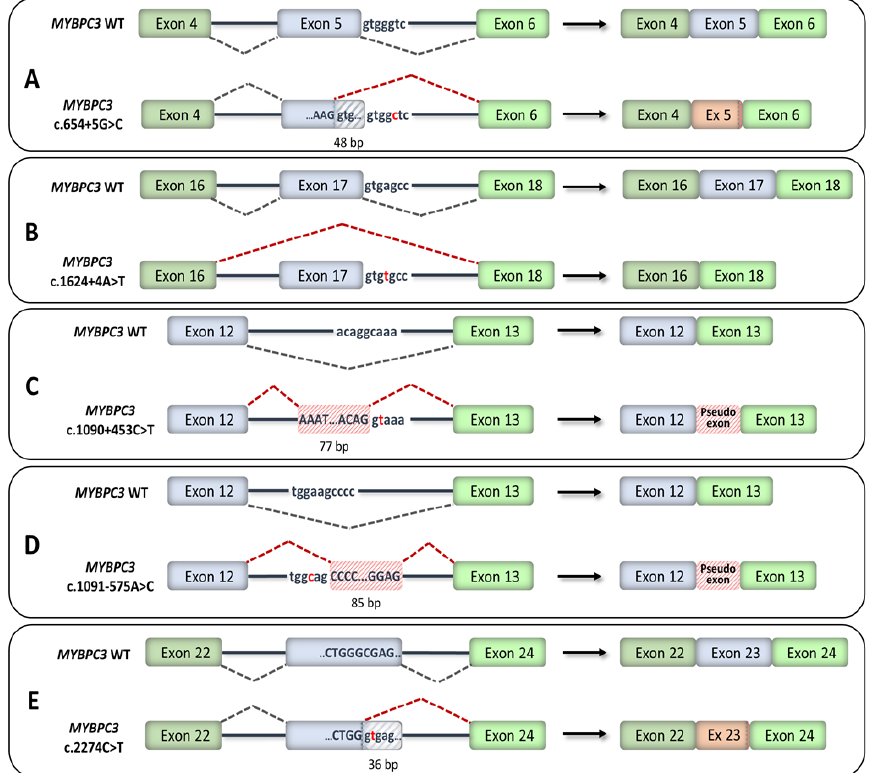
Figure 7. Recently reclassified MYBPC3 splicing mutations. Exons are represented by boxes and introns by lines. Exonic nucleotides are indicated by capital letters and intronic nucleotides by small-case letters. ( A ) Variant c.654 + 5G > C created a cryptic donor splice site within exon 5, leading to a truncated